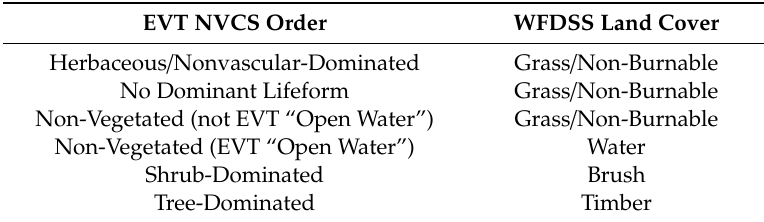
Figure 3. Study area map showing WFDSS land cover classes derived from the 30m LANDFIRE Existing Vegetation Type (EVT) dataset. Table 4. Lookup table for converting LANDFIRE EVT National Vegetation Classification Standard (NVCS) orders to WFDSS land cover types.